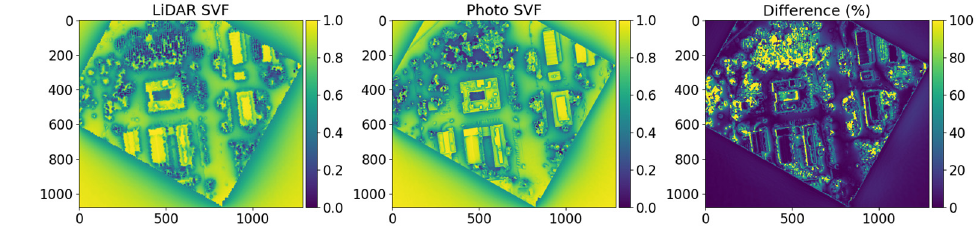
Figure 4. Comparison of sky view factors (SVF) computed from LiDAR and Photogravimetry DSMs.